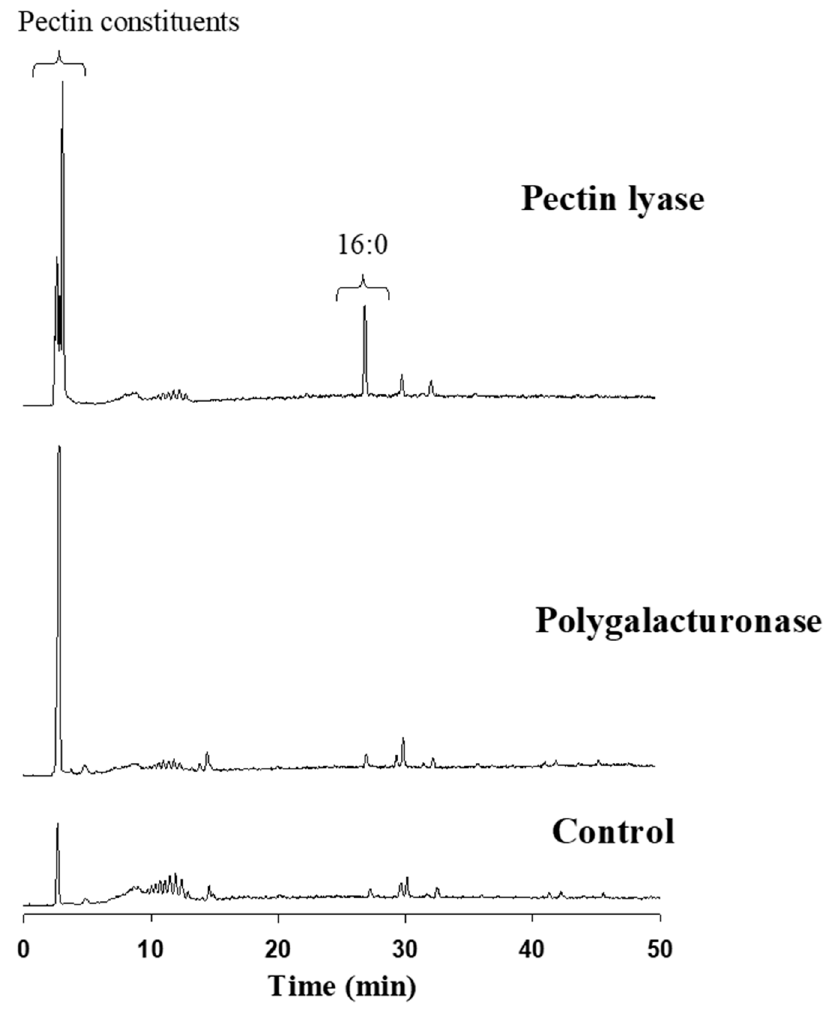
Figure 5. ELSD-RP HPLC separation of cutinase hydrolysis products. The analysis of a chloroform extract of the residual reaction solution followed the incubation of raw cotton fabrics with polyga- lacturonase (PG) and pectin lyase (PL). Reactions were carried out for 18 h at 37 °C with 20.06 U/mL PL or 10.74 U/mL PG and 800 mg fabric in 100 mM potassium phosphate buffer, pH 8 and 50 mM acetate buffer, pH 5, respectively. The control treatment did not contain an enzyme. Pectin hydrolysis products were observed by a major peak at 2.8–2.9 min, while the waxy layer major C:16 component peaked at ca 28 min in the PL treatment.